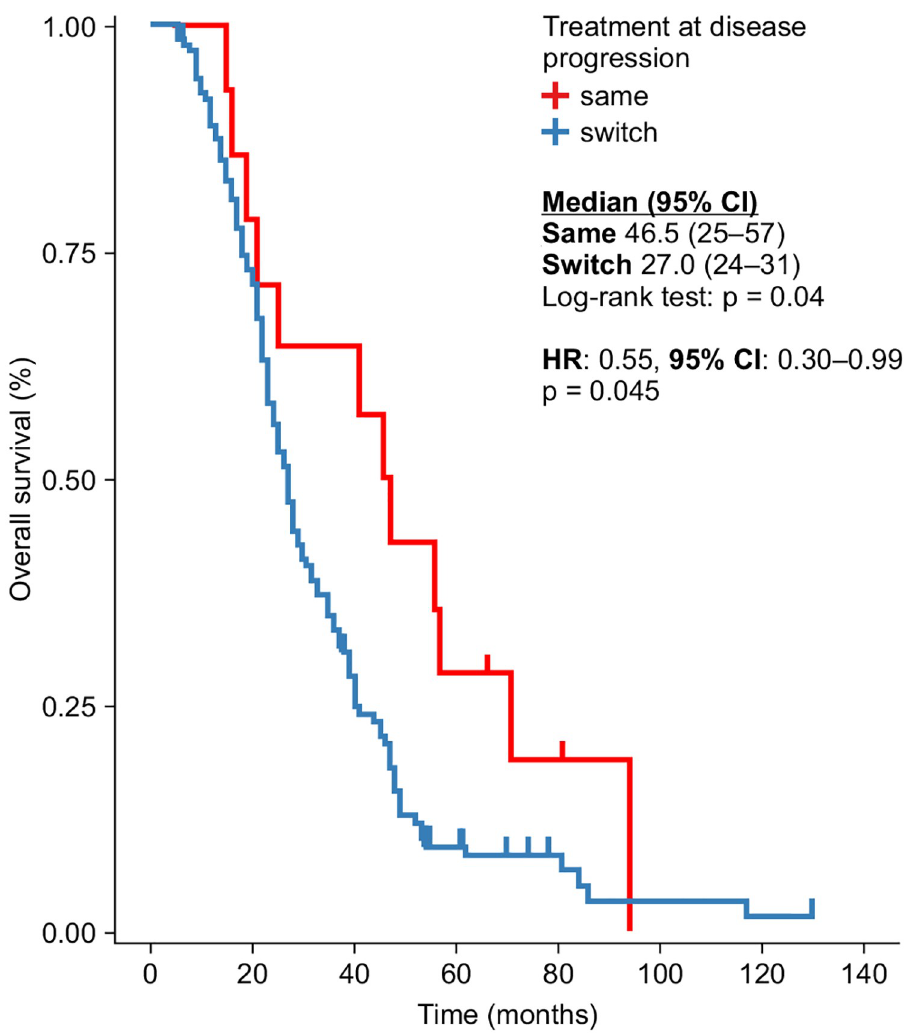
Fig 7. Overall survival in line with the concordance of first- and second-line treatment with bevacizumab dose.